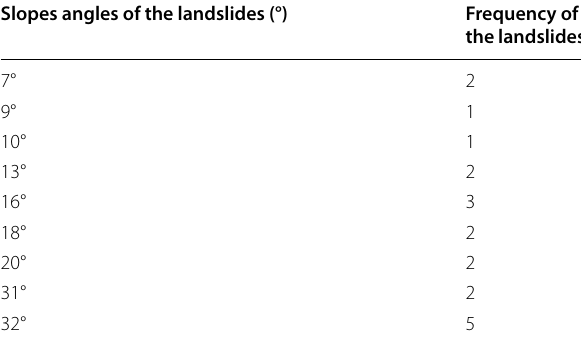
Table 2 Frequency of slope angles of the slides and gullies in study area (2020–2021) Slopes angles of the landslides